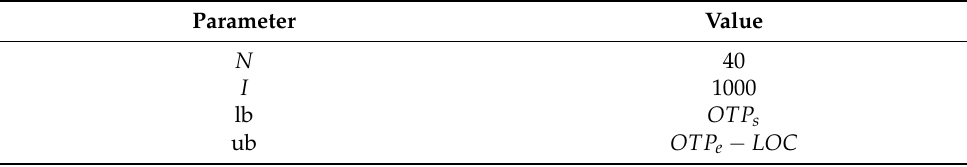
Table 4. Parameters used in GWO algorithm.